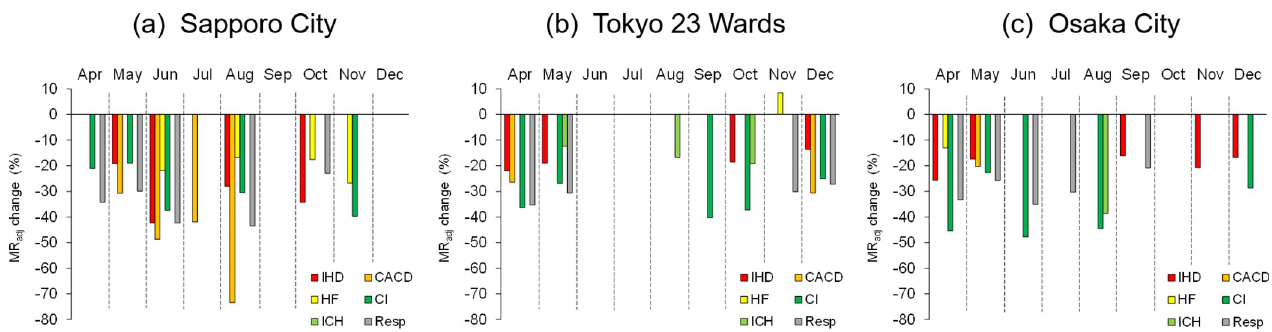
Fig 5. Statistically meaningful changes in MR adj of each disease in the temperature-sensitive months of April–December 2020. The results of acute ischemic heart disease (IHD) (red), cardiac arrhythmia and conduction disorder (CACD) (orange), heart failure (HF) (yellow), cerebral infarction (CI) (green), intracerebral haemorrhage (ICH) (light green), and respiratory diseases (Resp) (grey) are provided in (a) Sapporo, (b) Tokyo, and (c) Osaka. Here, only temperature-sensitive months (as indicated in Tables 2 and 3) are evaluated in each disease.